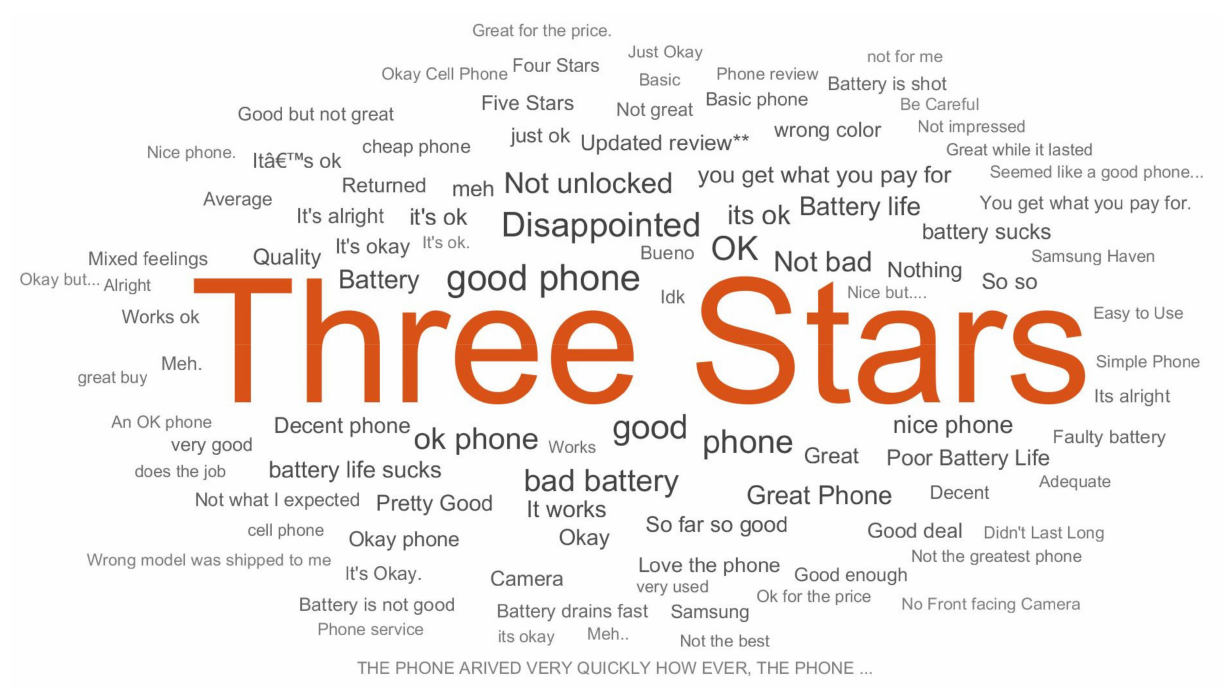
Figure 16. Word-cloud plot analysis for words with review score three.